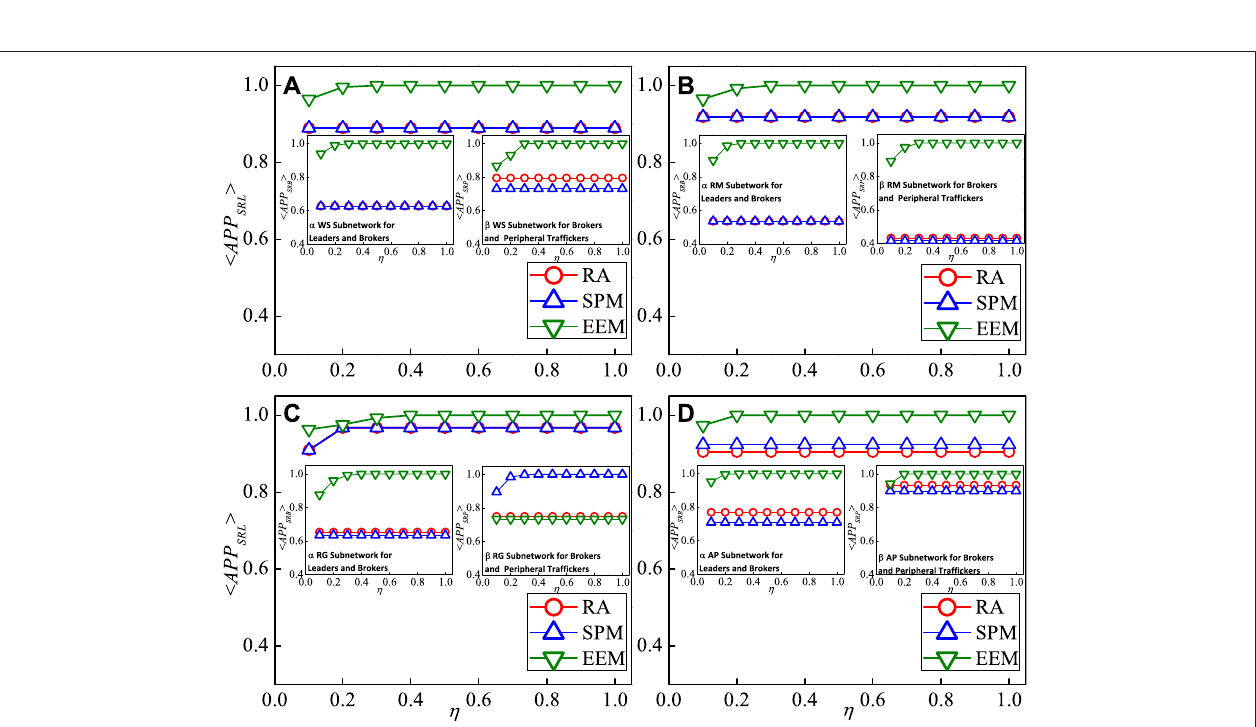
FIGURE 4 | (Color Online) The mean local indices of success rates 〈 APP SRL 〉 , 〈 APP SRB 〉 , and 〈 APP SRP 〉 of reconstructing four types of networks: (A) small-world networkwith120nodes, (B) randomnetworkwith120nodes, (C) regularnetworkwith120nodesand (D) Apolloniannetworkwith124nodes,hostingaPDGdynamical process. The lines with circle, triangle and inverted triangle symbols are the mean local indices of success rates 〈 APP SRL 〉 , 〈 APP SRB 〉 , and 〈 APP SRP 〉 obtained by RA, SPMand EEMbasedon90%prioristructure information.Themeanreconstruction accuracyindicesareachievedbyaveragingover50independentexperimental results. For each experiment, measurements are randomly picked from a time series of temporary evolution. The index of information suf fi ciency rate η indicates the amount of the available time-series information used in the reconstruction. The payoff parameter for the PDG is b (cid:1) 1.2.